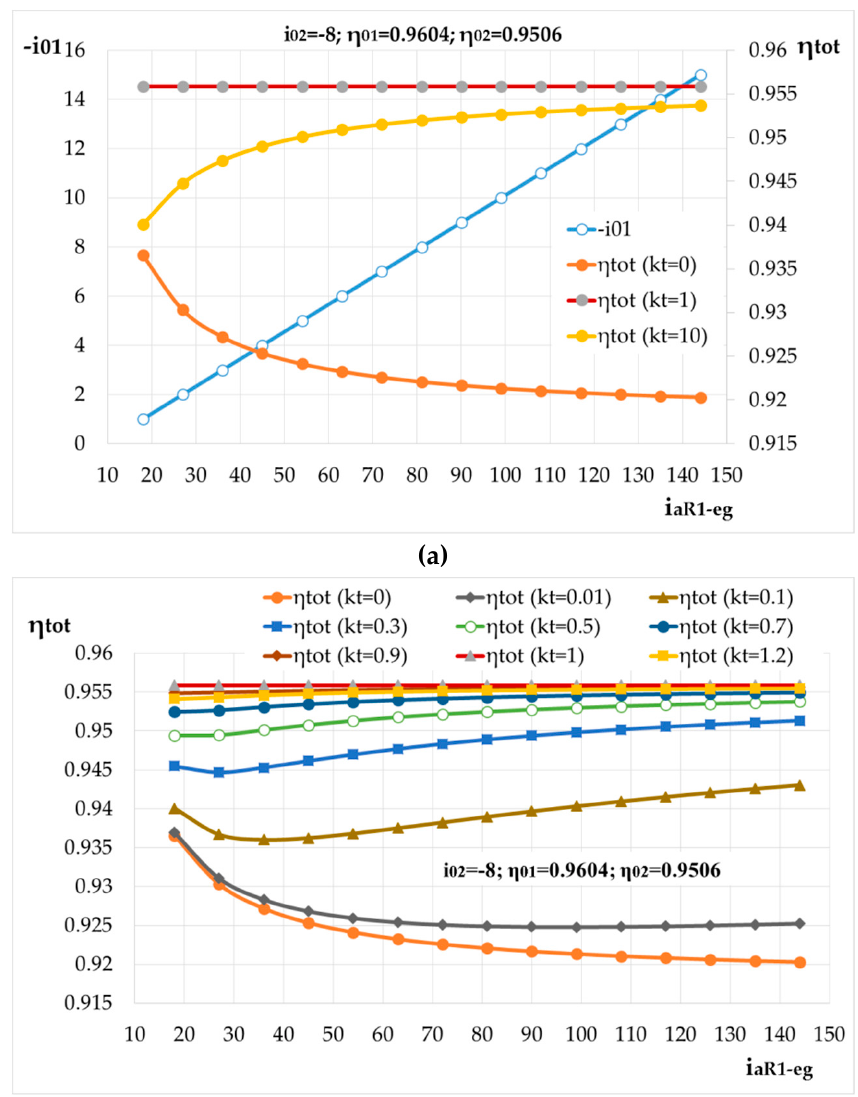
Figure 4. The variation of the speed increaser efficiency as a function of the amplification kinematic ratio: ( a ) for three representative values of the k t ratio; ( b ) for k t ≤ 1.2.